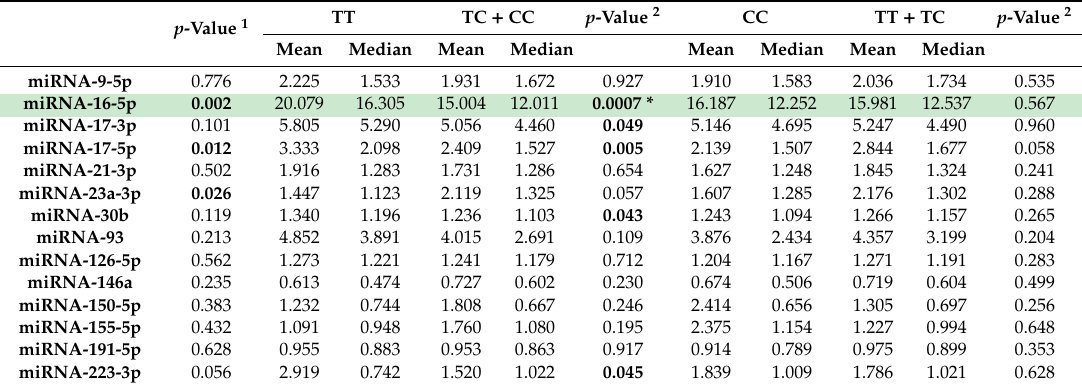
Table 6. Plasma miRNA expression profiles in patients with di ff erent alleles in CFH Y402H.